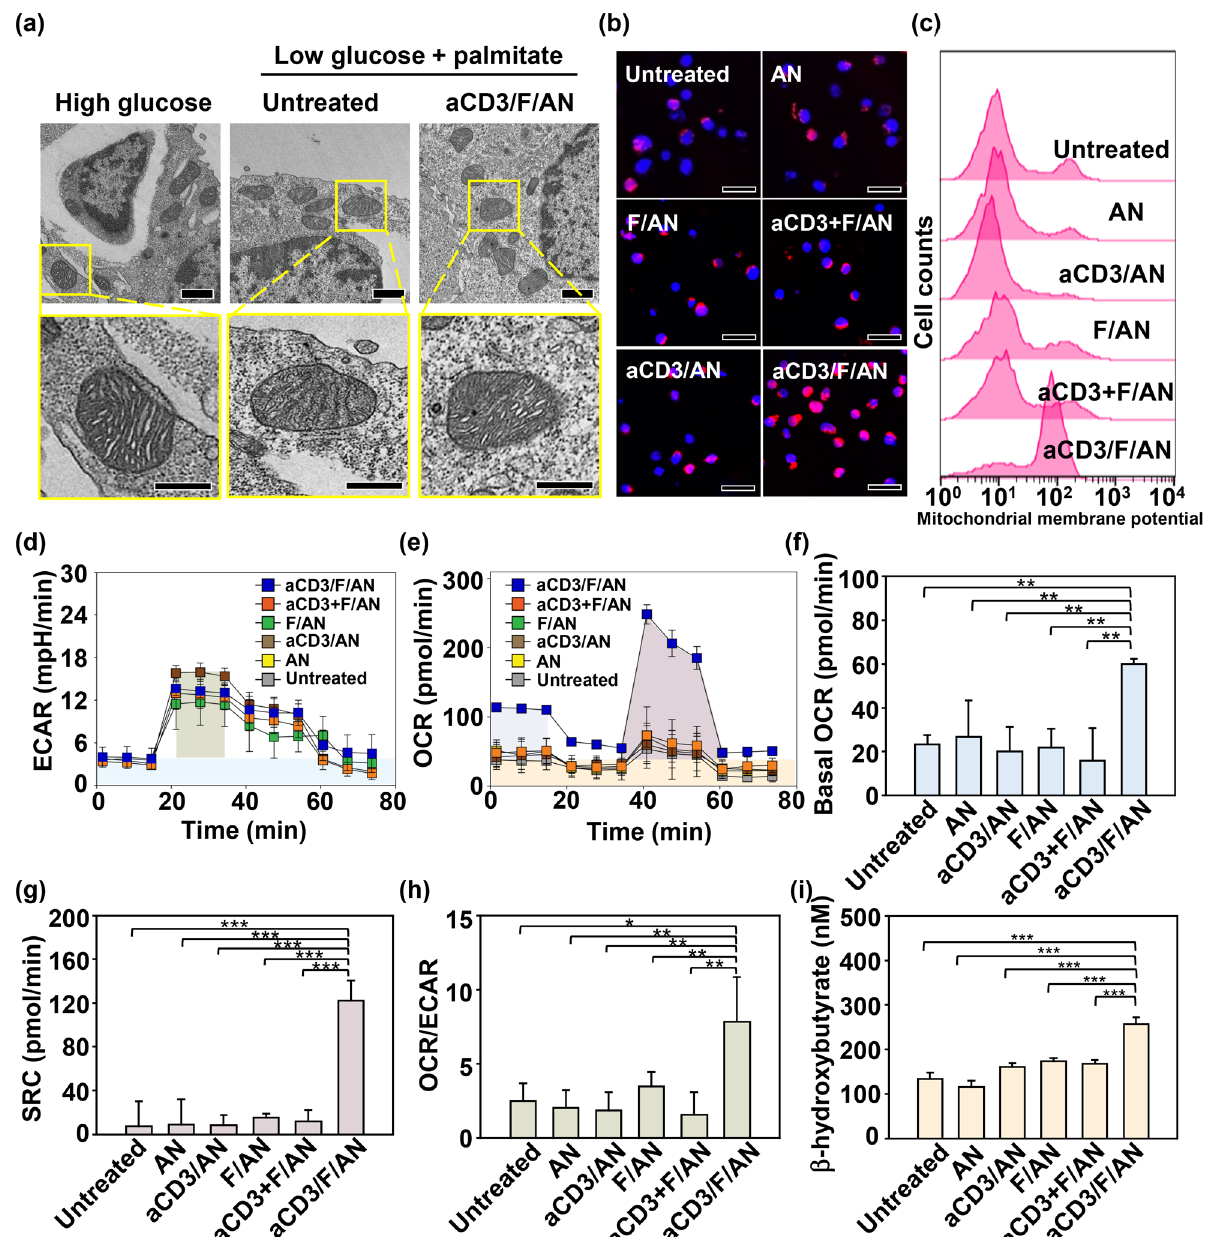
Fig. 5 Mitochondrial morphology, membrane potential and fatty acid metabolism in T cells. T cells were treated with aCD3/F/ANs in low‑ glucose medium supplemented with palmitate as a lipid source. a TEM showing mitochondria of T cells in high‑glucose medium, low‑glucose medium untreated or treated with aCD3/F/AN. Scale bar: 1 μm (upper panels) and 500 nm (lower panels). b Mitochondrial membrane potential, assessed using MitoTracker Orange CMTMRos and visualized by confocal fluorescence microscopy. c Populations of T cells with increased mitochondrial membrane potentials, quantified by flow cytometry. d, e ECAR ( d ) and OCR ( e ), measured using a Seahorse XFp analyzer. f–h Basal OCR ( f) , SRC ( g) and OCR/ECAR h values, obtained based on ECAR and OCR values (*P < 0.05, **P < 0.01). i β‑Hydroxybutyrate secretion levels (***P <